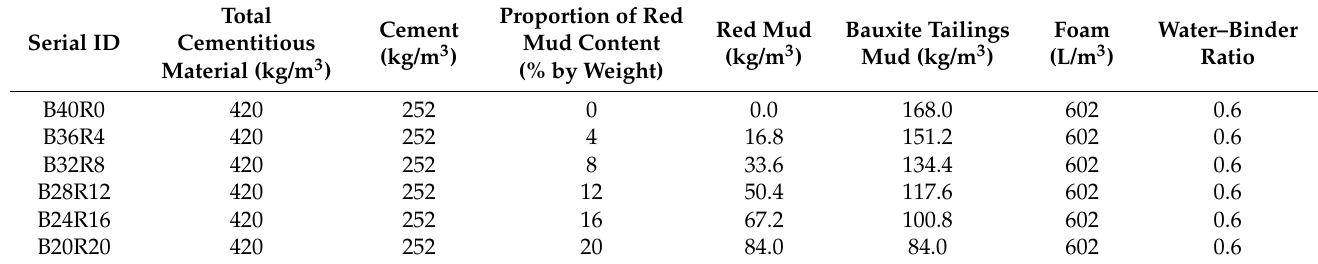
Table 2. Proportions of red mud and bauxite tailings mud of lightweight